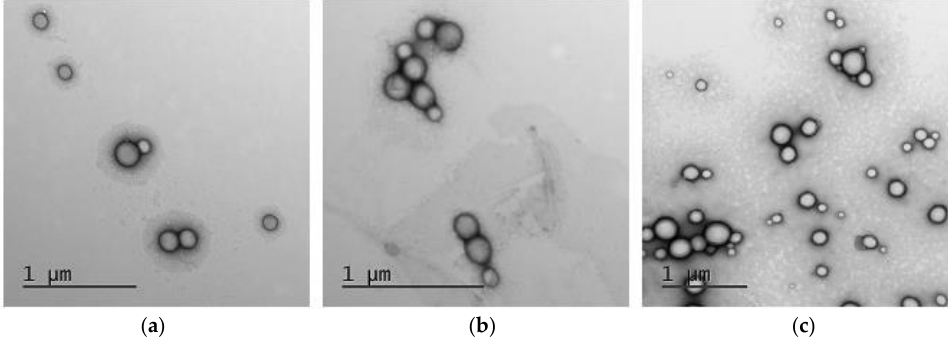
Figure 9. TEM images: empty mPEG- b -PLA nanoparticles ( a ); mPEG- b -PLA-based DOD nanoformulation ( b ); mPEG- b -PCL-based DOD nanoformulation ( c ). The diameter of empty mPEG- b -PLA and DOD/mPEG- b -PLA in a dry state was 113 ± 20 nm and 125 ± 35 nm, respectively. The hydrodynamic diameters for these nanopar- ticles were 115 nm (Table 2) and 118 nm (Table 3, the initial DOD amount was 50 μg/mg of polymer), respectively. In turn, DOD/mPEG- b -PCL nanoparticles in a dry state had a diameter of 104 ± 27 nm, which is also close to the DLS results: D H = 105 nm (Table 3, the